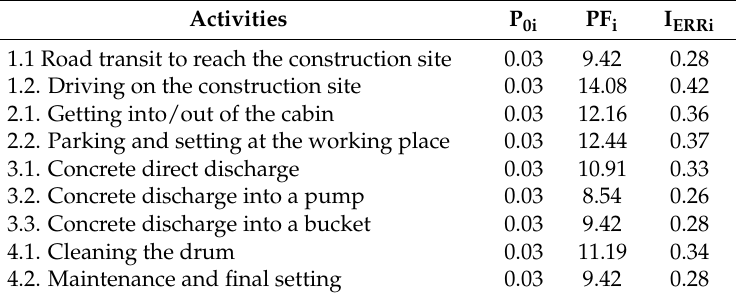
Table 4. Values of the human error probability index (I ERRi ).